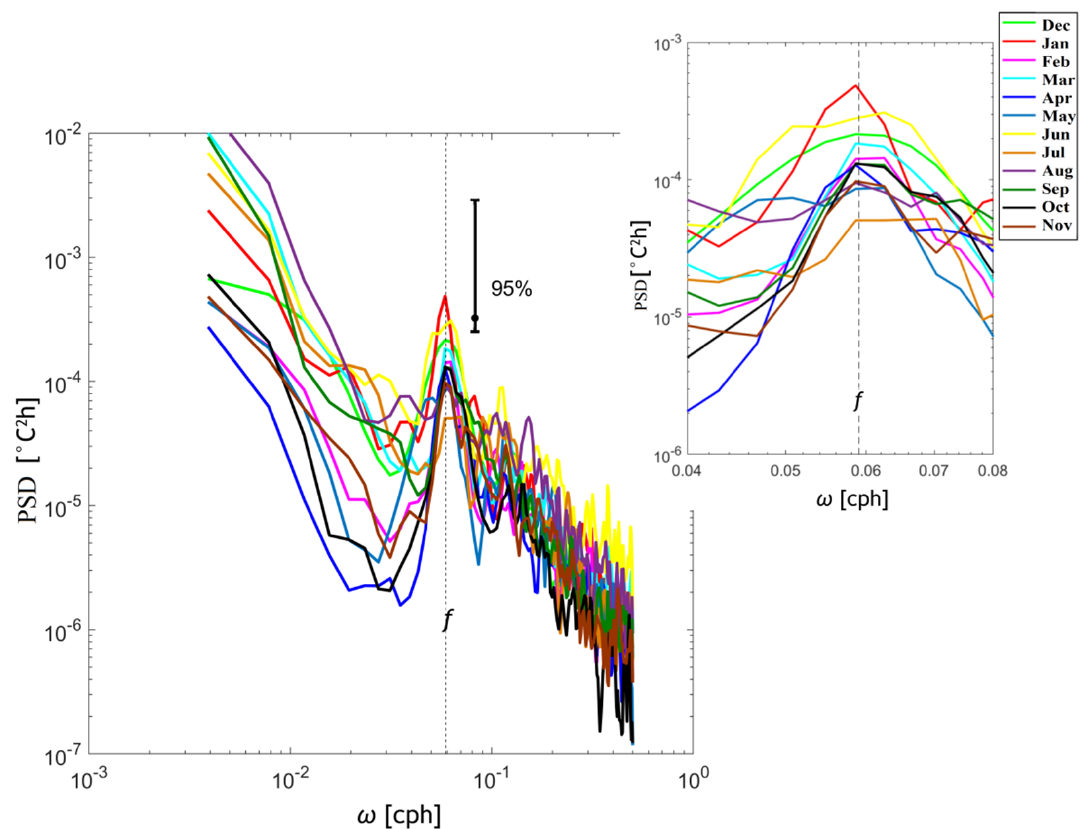
Figure A4. Power spectra of temperature fluctuations at 265 m depth at ABS No. 2 for different months. The dashed line indicates the local inertial frequency at the mooring site. The small image in the upper right corner is an enlargement of the figure to better visualize the peaks close to the inertial periods.